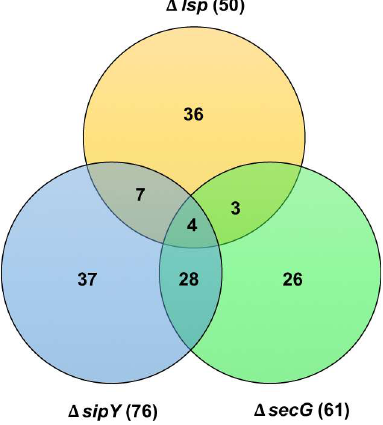
Figure 3. Venn diagram summarizing the relative degree of coincidence among the genes transcriptionally affected in the Streptomyces lividans SipY, SecG, or Lsp deficient strains. For comparative purposes, the set of genes involved in the stringent response in the Lsp deficient strains have been subtracted.